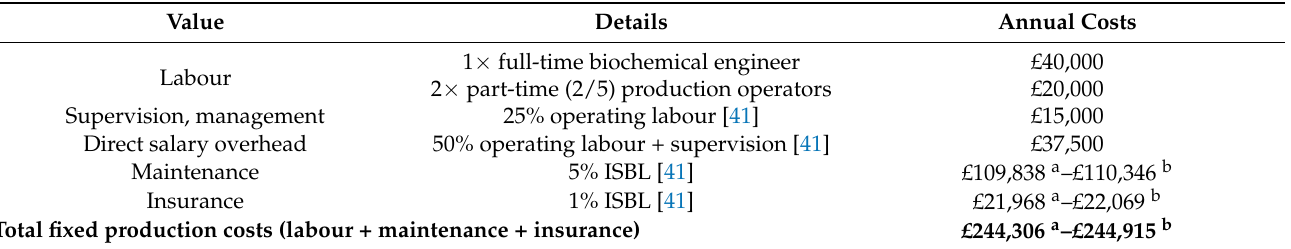
Table A3. Fixed production costs for the freeze-drying and spray-drying strategies. Values provided are identical for both strategies unless otherwise